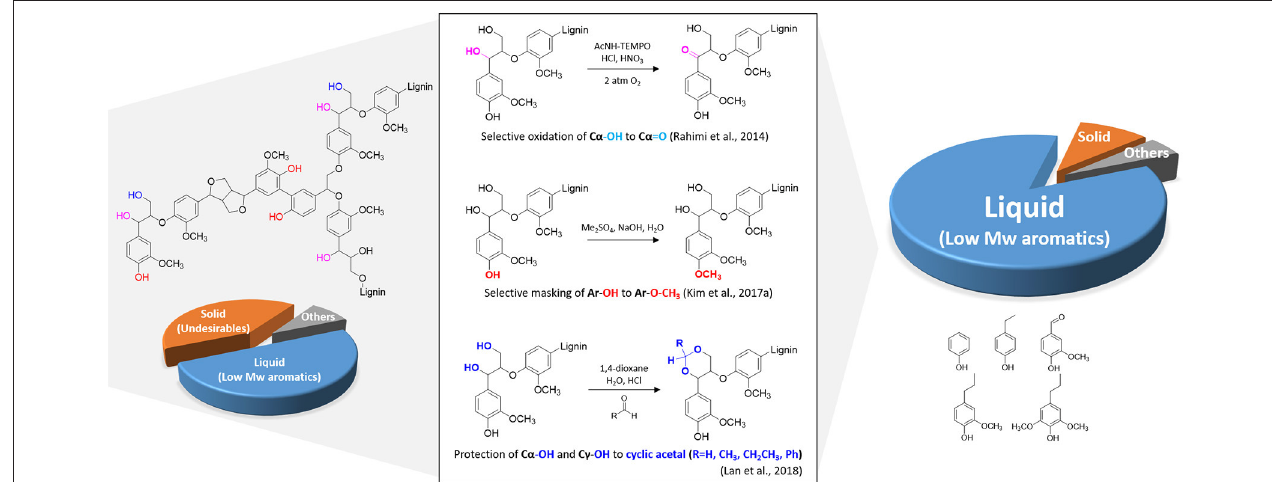
FIGURE 2 | Chemoselective structural modification of lignin for maximizing the value.